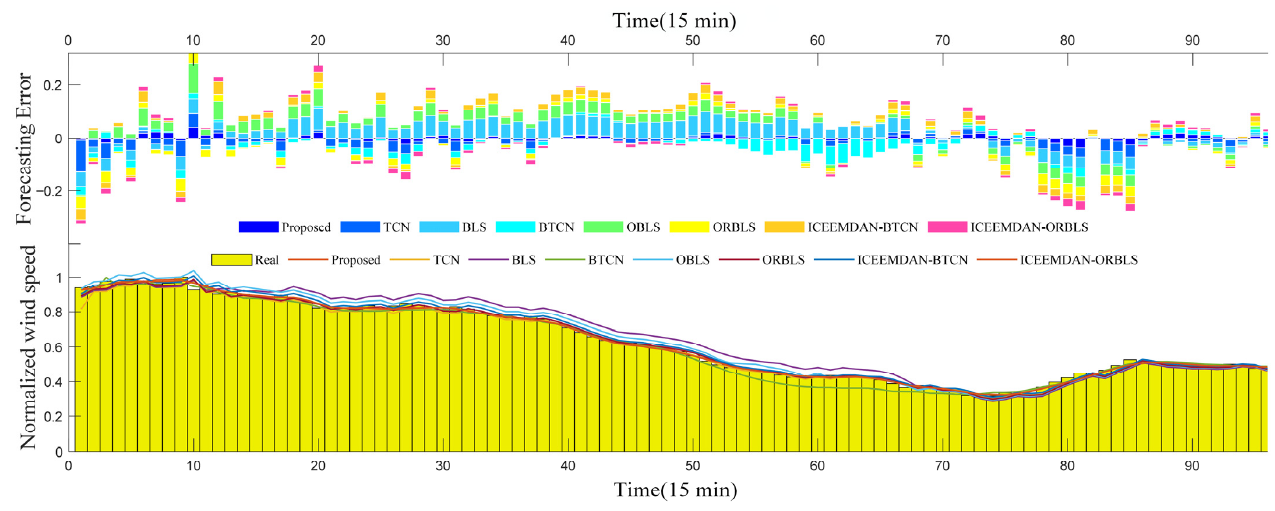
Figure 6. Forecasting results in HER dataset (22 September 2019).